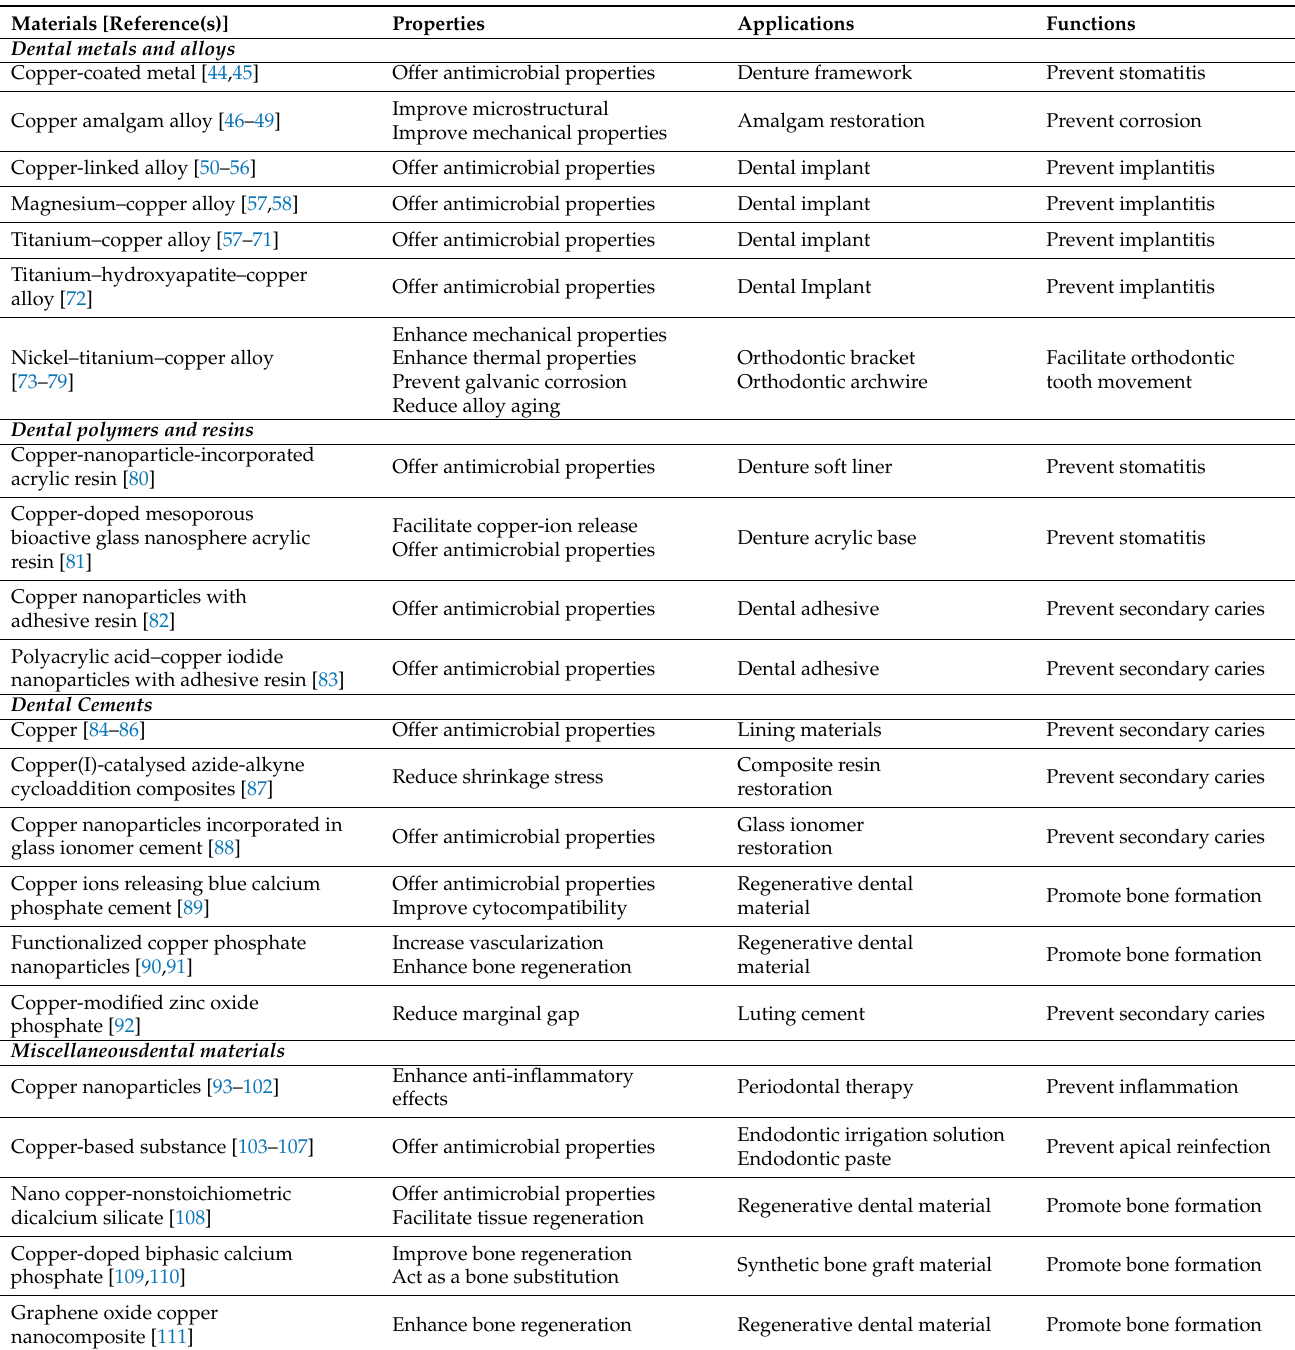
Table 1. Properties, applications, and functions of dental materials with copper